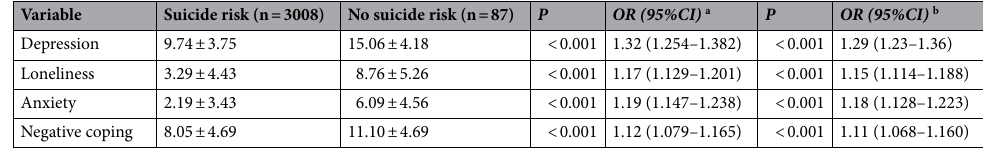
Table 2. Adjusted and unadjusted association of mental scale scores with suicide risk among migrant workers d ( x ± s ) . USL-6, Short-form of the ULCA Loneliness Scale; PHQ-9, Patient Health Questionnaire; GAD-7, Generalized Anxiety Scale; Negative coping style is the total score of items 13–20 on SCSQ scale. a univariate logistic analysis; b multiple Logistic analysis adjusted for age, education, marital status, religious belief, mental health service, living status, and alcoholism.